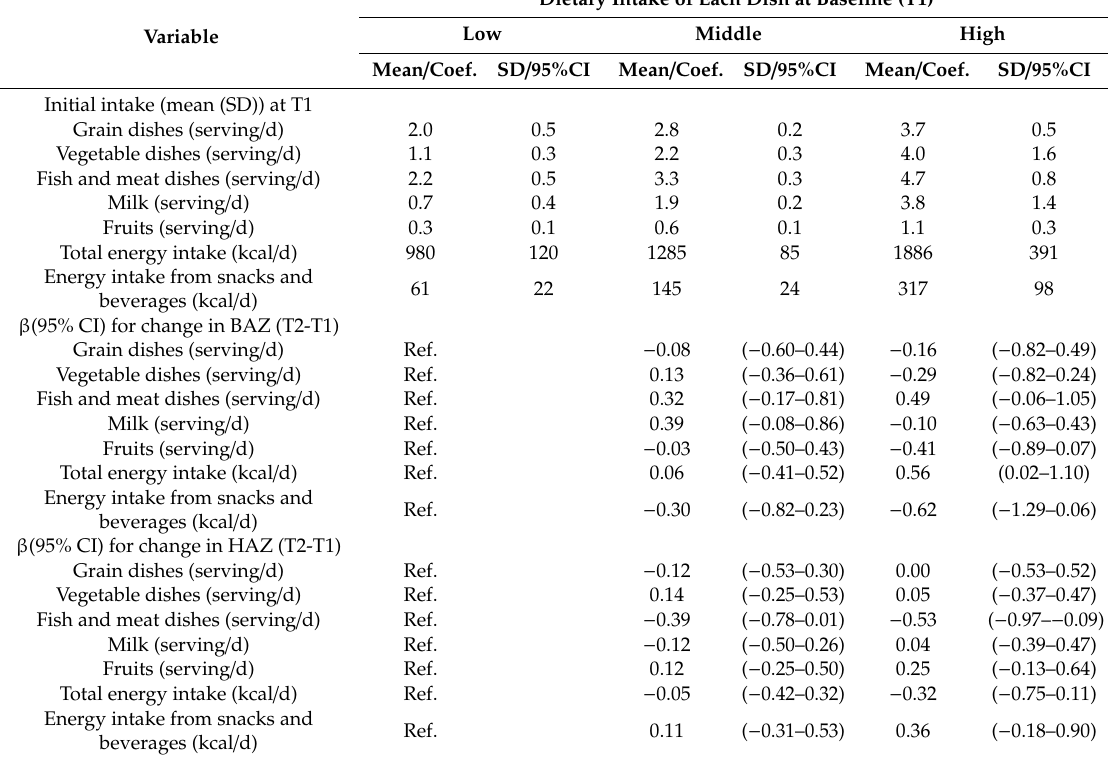
Table 5. Distribution of the intakes of each dish category according to dietary intake level of each dish at baseline (T1) and association between dietary intake of each dish (T1) and change in BAZ and HAZ